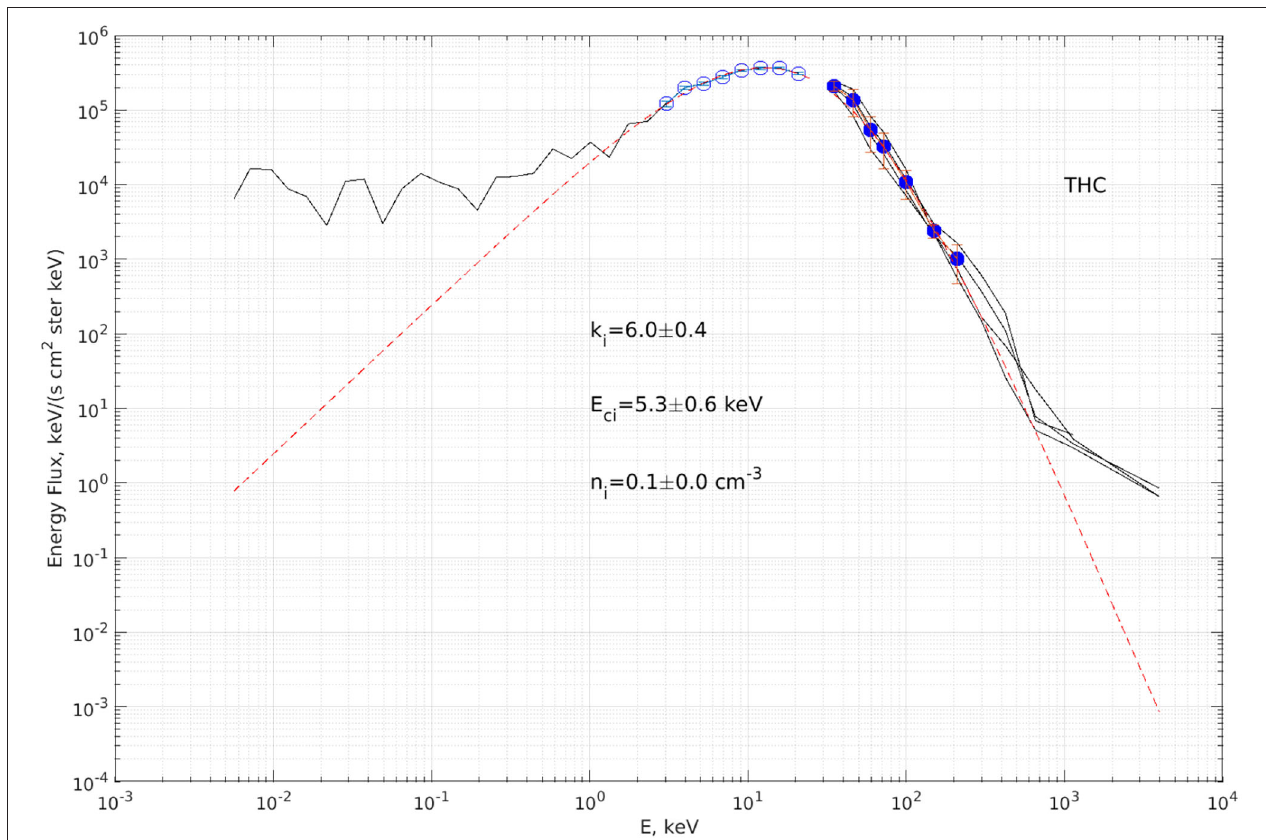
FIGURE 1 | Example of the fit of κ distribution to the flux spectra of ions measured by THEMIS-C (THC), on 14th February 2008, at 12.8 UT, GSM coordinate − ( X , Y , Z ) = ( 15.8, 0.82, 4.10) R E . The solid black lines are sub-datasets taken over a total of 12 min. Open circles represent averages of the subsets − − − measurements of low energy particles (ESA), and filled circles represent averages of the subsets of measurements of high energy particles (SST). The red dash-line is the Kappa function curve fitted to the open and filled